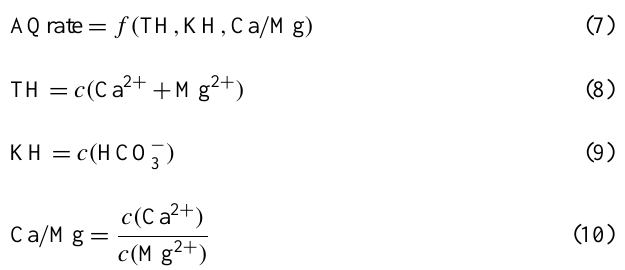
Figure 13. Dependence of the conductance on detergent concentra- tion